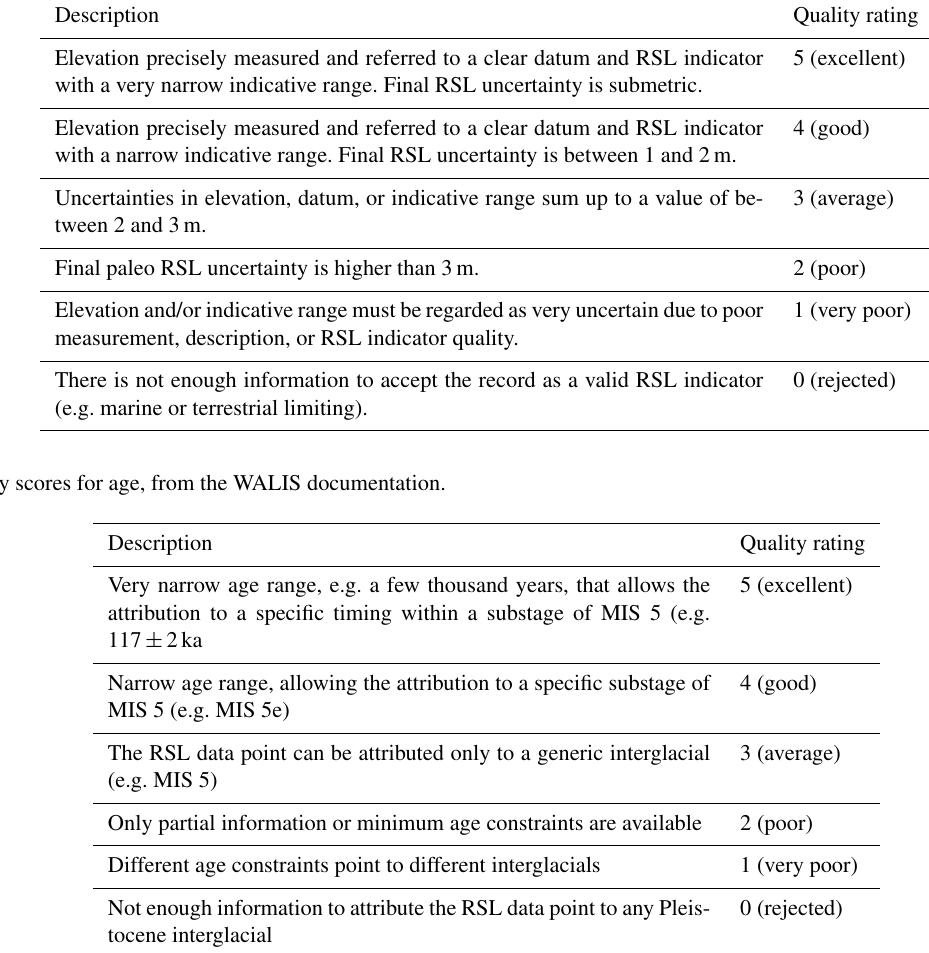
Table 4. Quality scores for RSL, from the WALIS documentation. Description Quality rating Elevation precisely measured and referred to a clear datum and RSL indicator with a very narrow indicative range. Final RSL uncertainty is submetric. Elevation precisely measured and referred to a clear datum and RSL indicator with a narrow indicative range. Final RSL uncertainty is between 1 and 2m. Uncertainties in elevation, datum, or indicative range sum up to a value of be- tween 2 and 3m.